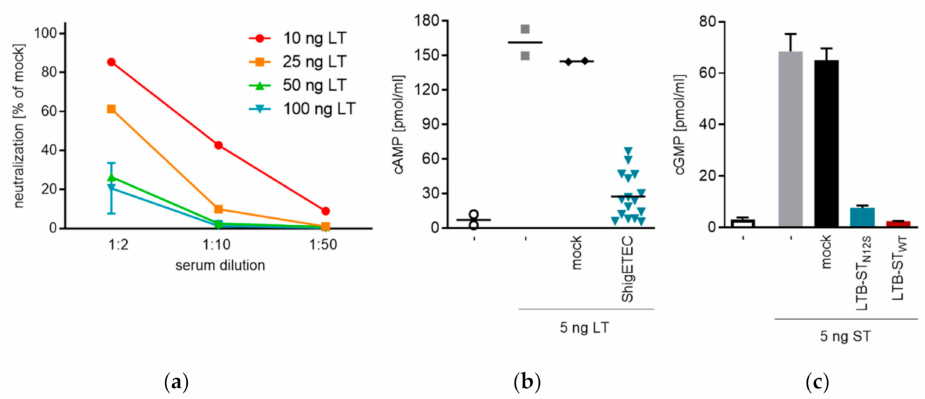
Figure 6. Toxin neutralizing capacity of mouse sera induced by ShigETEC vaccination. ( a ) Mice were vaccinated 3 times i.n. with 10 8 CFU ShigETEC. Serum at indicated dilutions was incubated with indicated amounts of LT, and LT-binding to GM1 coated plates was measured. Bound LT was detected with a polyclonal anti-cholera toxin antibody. ( b ) Sera from individual mice (3 times i.n. vaccinated with 10 8 CFU ShigETEC (blue symbols) or bu ff er (mock, black symbols) were pre-incubated with the 5 ng LT. LT induced cAMP release was measured in T84 human colon epithelial cells. ( c ) 5 ng synthetic ST was pre-incubated with pooled serum from mice vaccinated i.p. with LTB-ST N12S (blue bar) or LTB-ST WT (red bar) protein or vehicle (mock). ST-induced cGMP release was measured in T84